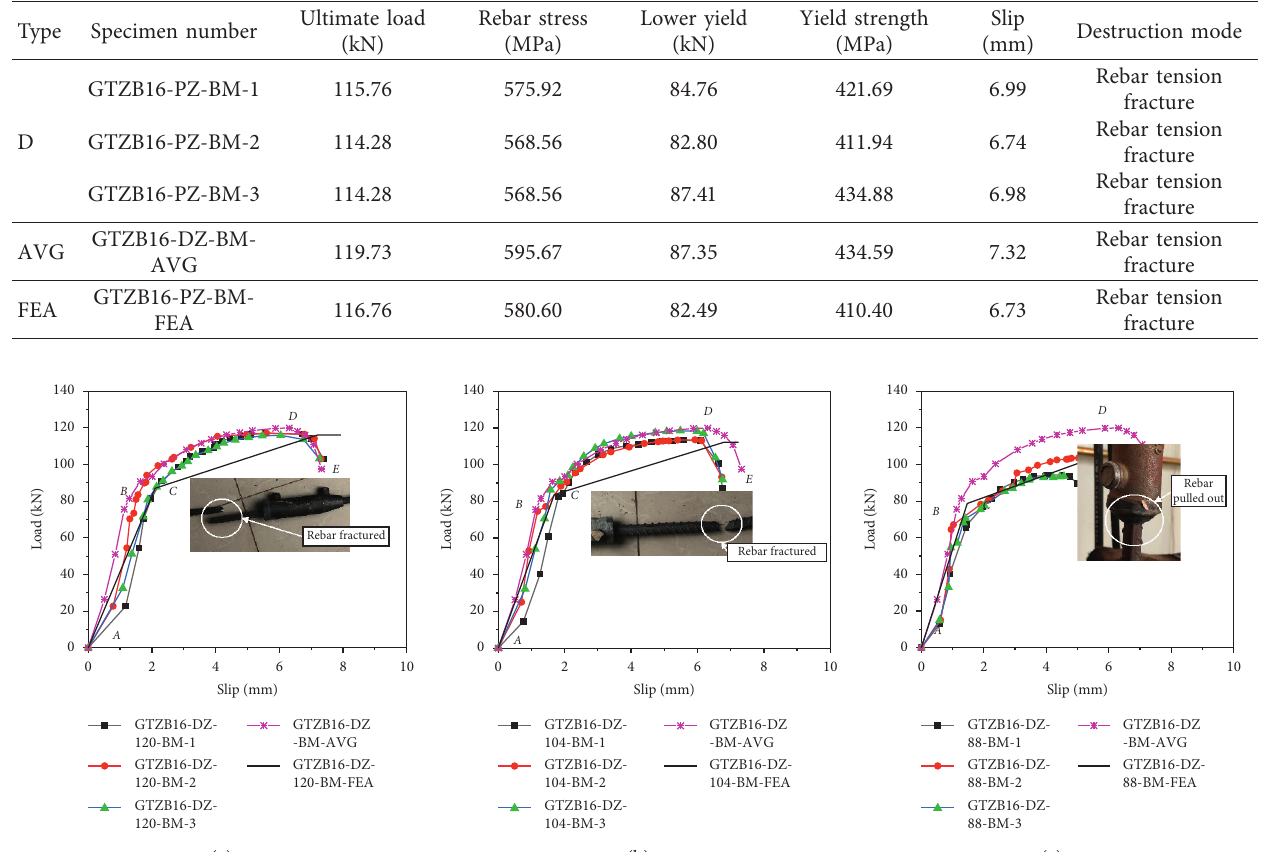
Table 7: Experiment and stimulation data of the rebar offset joint specimen.